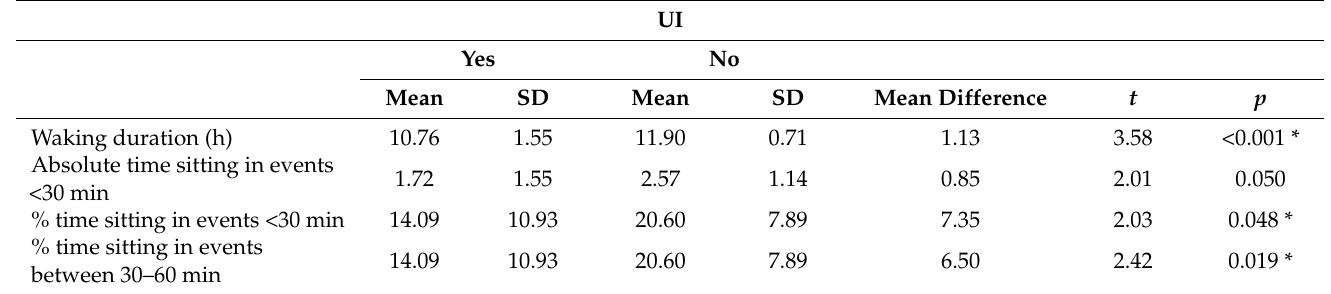
Table 6. Association between urinary incontinence (UI) and parametric variables with the